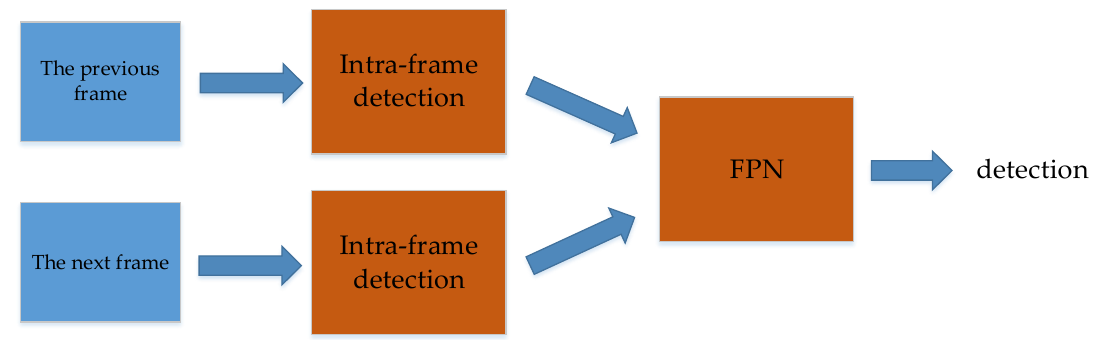
Figure 7. The workflow of FastUAV-NET.